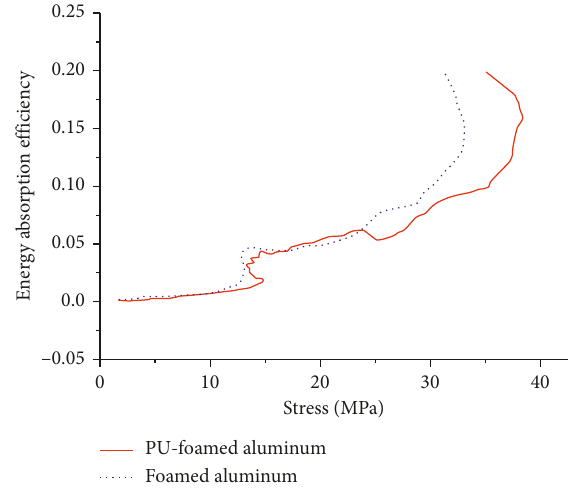
Figure 28: Energy absorption efficiency-stress